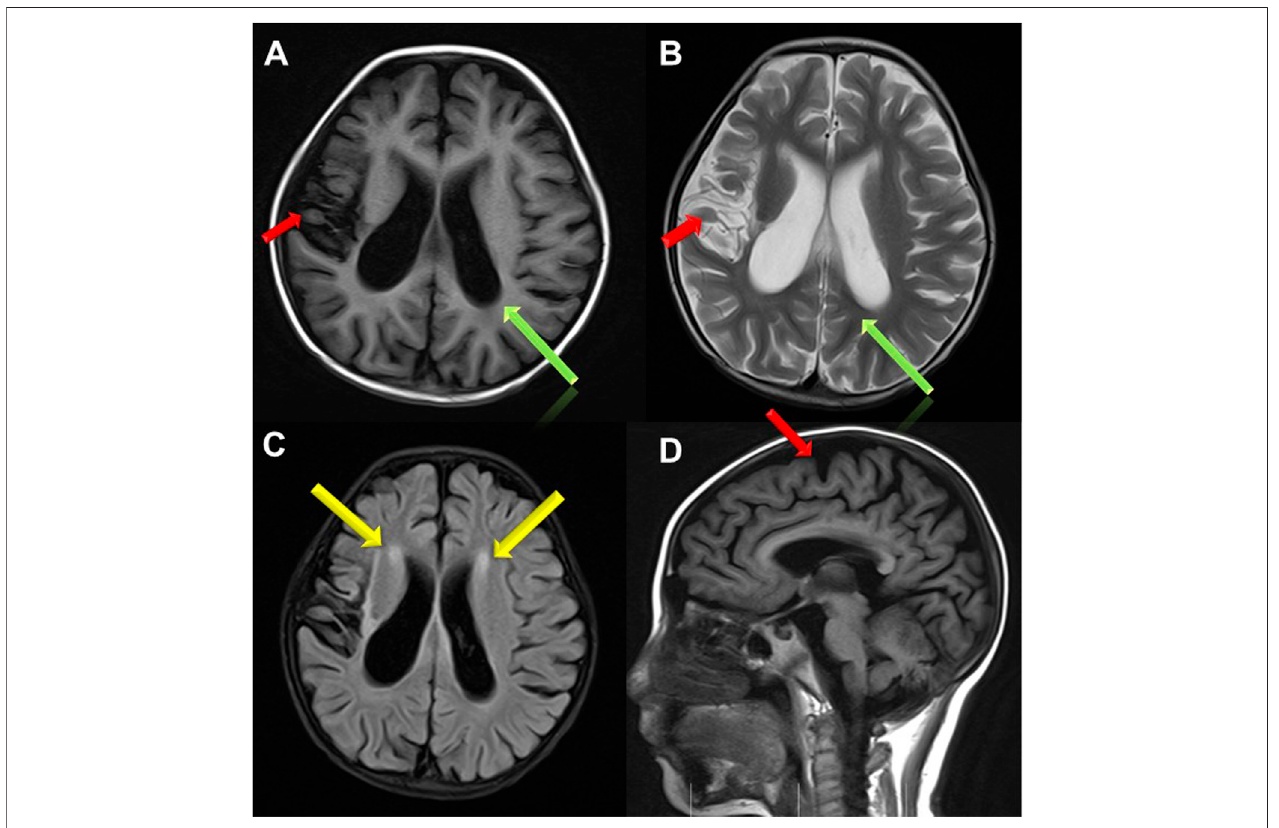
FIGURE 1 | Brain MRI images. (A,B,D) Brain atrophy was found in Transverse T1 and T2 weighted image and Sagittal T1 weighted image(the red arrow); Sulci fi ssure widened and deepened in Transverse T1 and T2 weighted image (the green arrow); (C) High signal in white matter near to bilateral periventricular in FLAIR sequence (the yellow